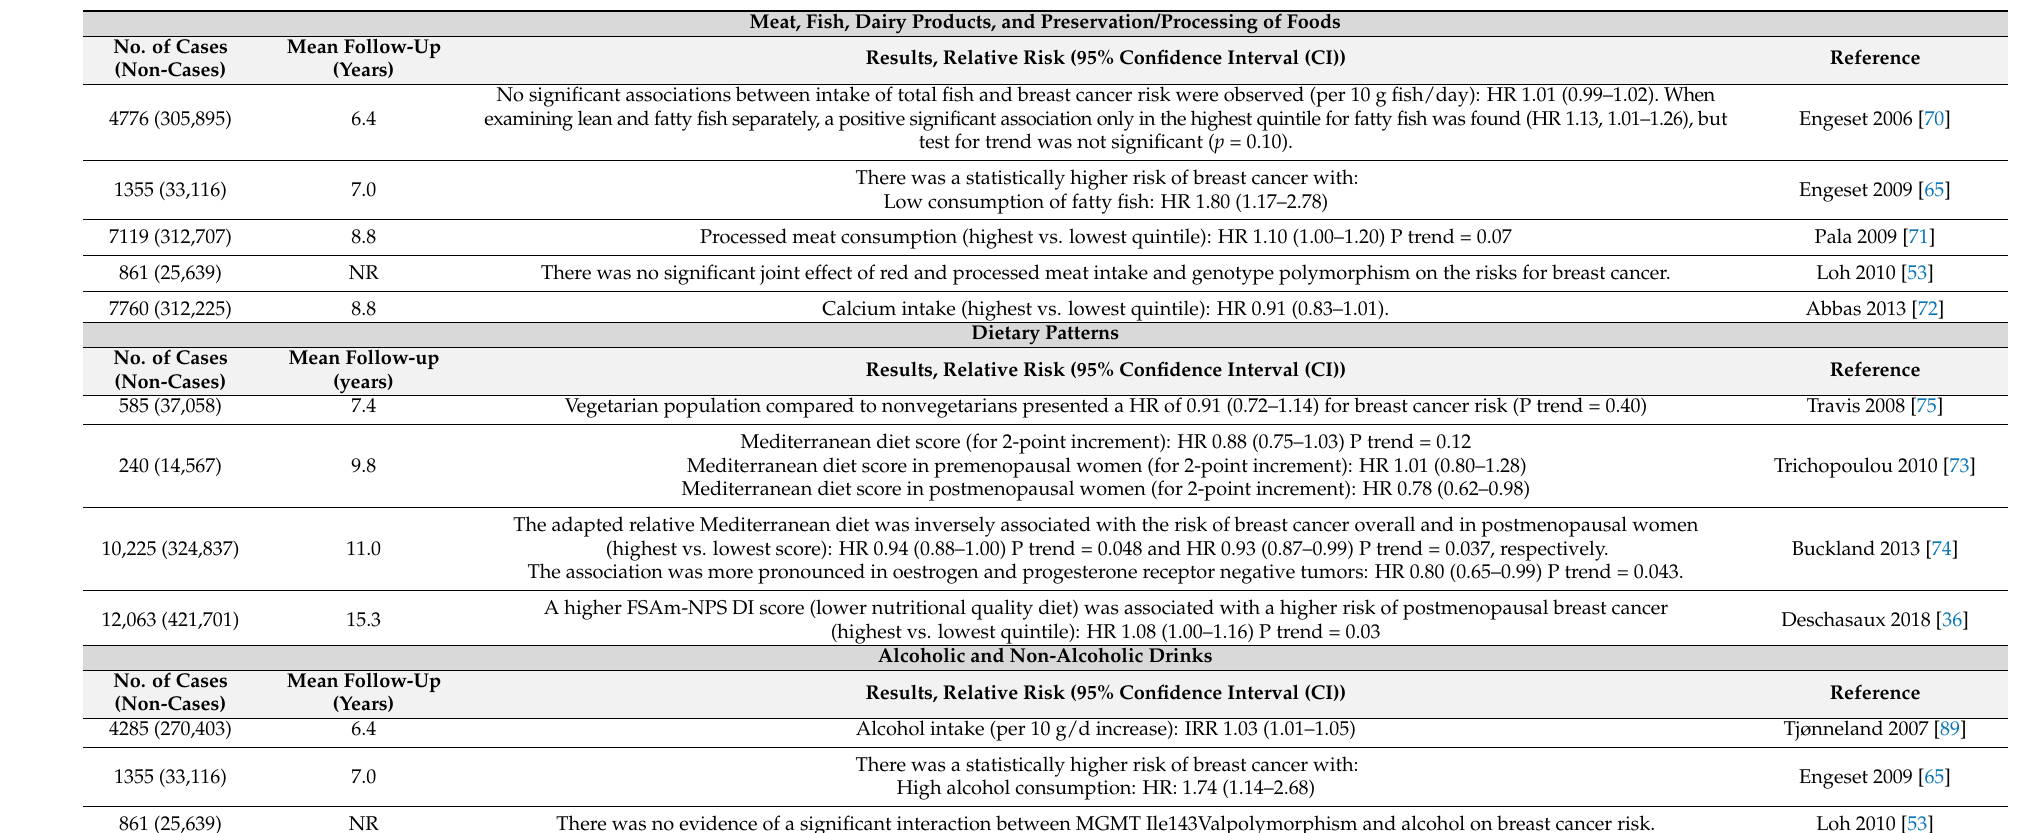
Meat, Fish, Dairy Products, and Preservation/Processing of Foods